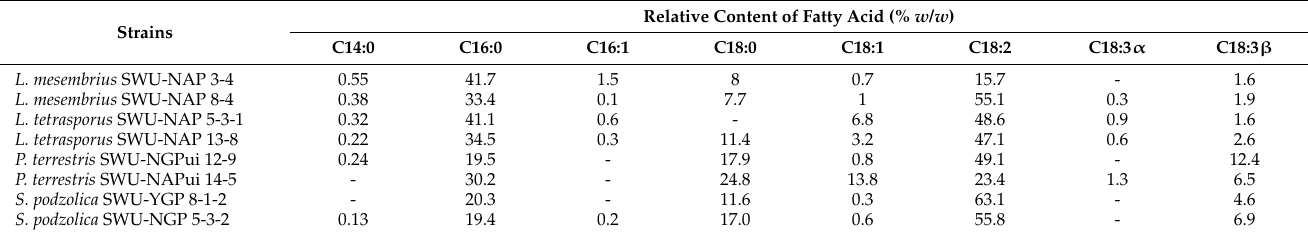
Table 4. Fatty acid composition of lipids produced by the selected oleaginous yeast